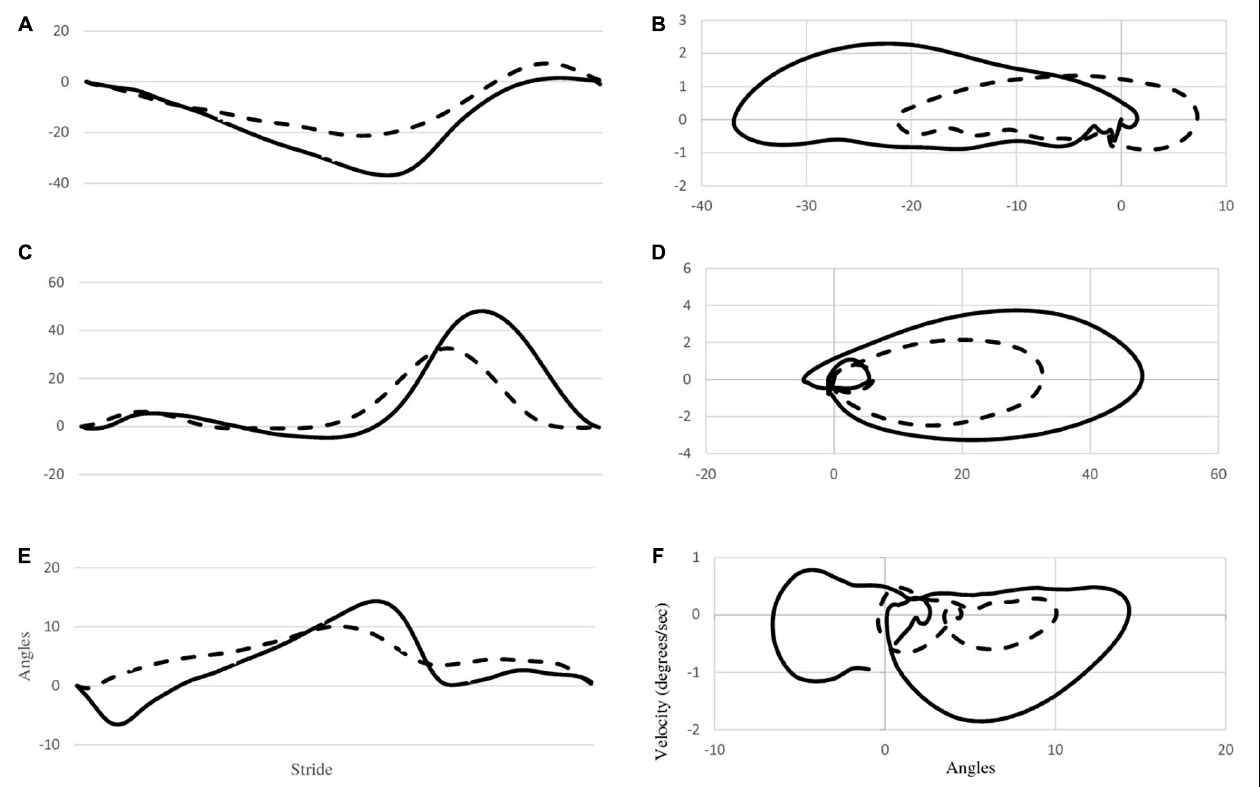
FIGURE 2 | The first column (A,C,E) depicts mean joint angle waveforms of the right hip, knee and ankle for both P1 (dashed line) and P2 (solid line). The second column (B,D,F) depicts phase portraits for the right hip, knee and ankle for both participants.